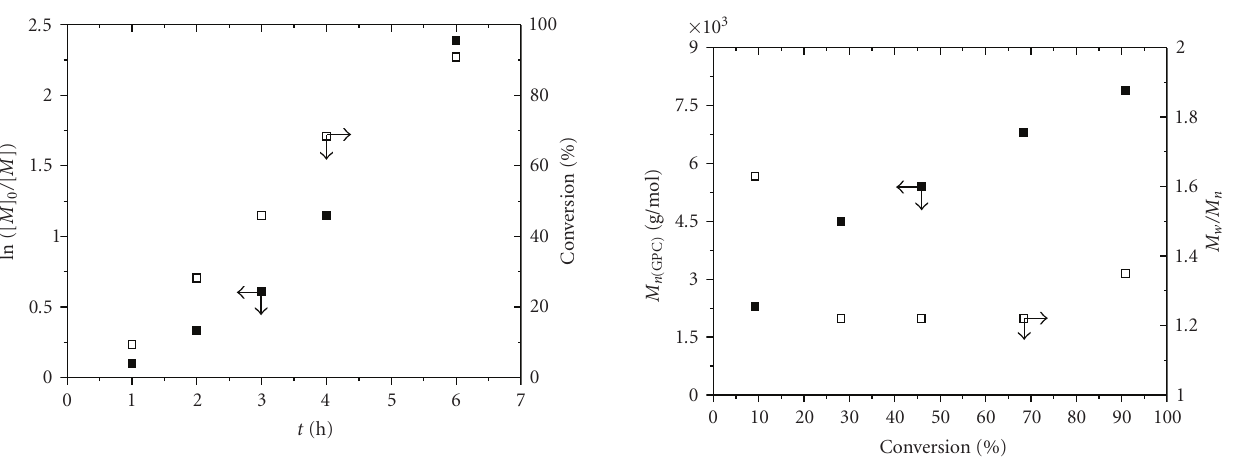
Figure 1: ln([ M 0 ]/[ M ]) and monomer conversion versus polymer- ization time. Kinetic plot of RAFT copolymerization of HQHEMA and MMA. Polymerization conditions: [Monomer] 0 /[CPDN] 0 / [AIBN] 0 = 1000 :10: 1, [Monomer] 0 = [MMA] 0 /[HQHEMA] 0 = 10:1; T = 70 ◦ C.